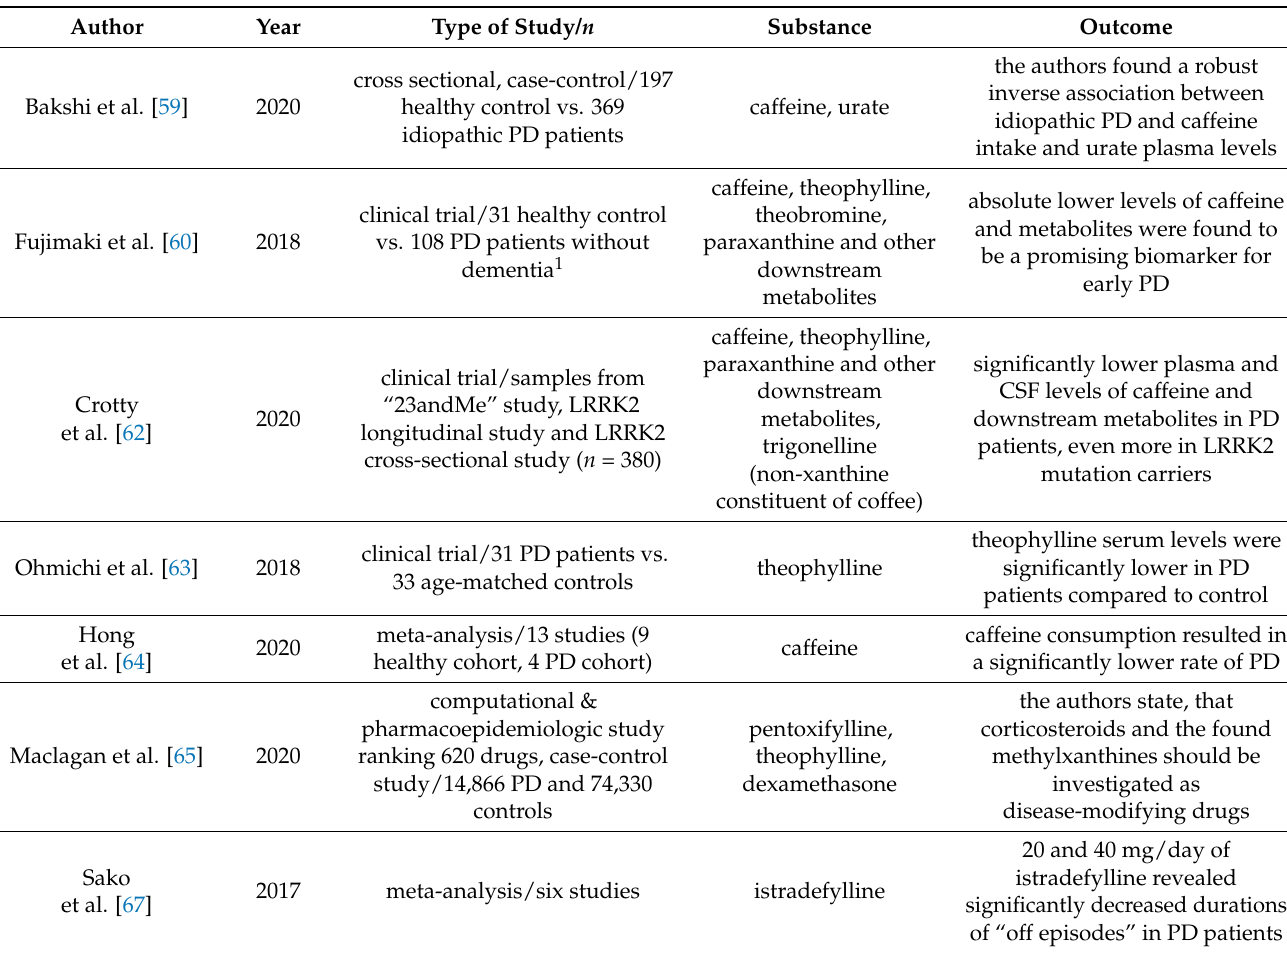
Table 3. Summary of recent clinical studies investigating the relationship between methylxanthines and Parkinson ´ s Disease (PD). n : sample size; CSF: cerebrospinal